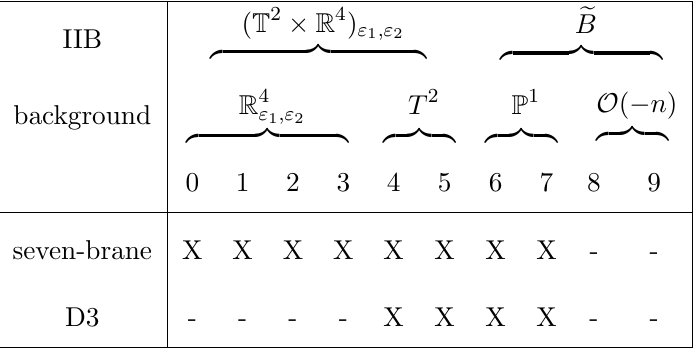
Figure 5 . Schematic IIB description of the 6d (1,0) (cid:10)